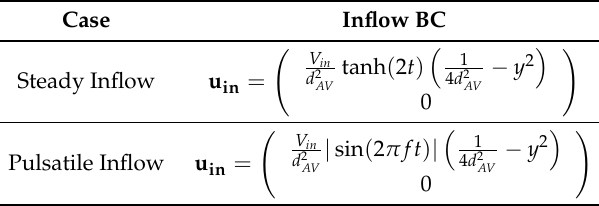
Table A1. Inflow boundary conditions for both simulations, one pertaining to parabolic steady inflow and the other corresponding to a parabolic pulsatile inflow. The parameters used for the boundary conditions are f , the non-dimensional frequency, which is matched to the zebrafish heart at 96 hpf, and V in , the maximum inflow velocity. Case Inflow BC Steady Inflow